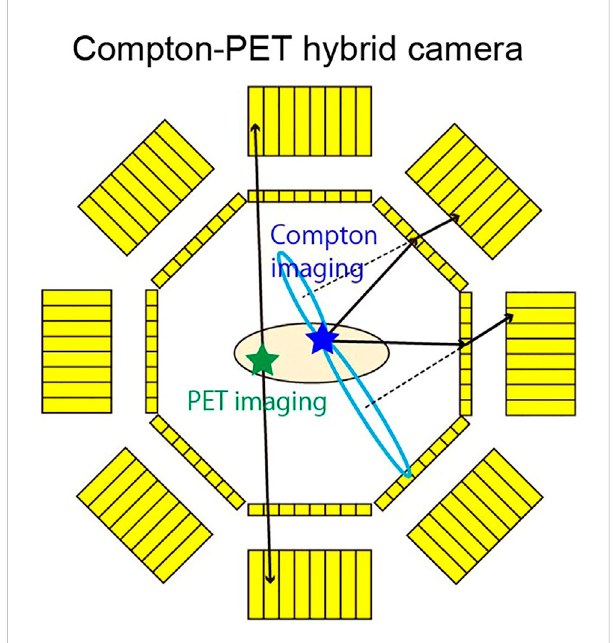
FIGURE 9 Compton-PET Hybrid camera. Both PET and SPECT tracers can be imaged with this camera. The thick yellow boxes represent absorbers. The thin yellow boxes represent scatterers. Coincident detection of annihilation photons (green star and black arrows) is done via the absorbers, similar to traditional PET systems. SPECT tracers (blue star) are visualized by using coincident detection of a scattered gamma ray in a scatterer, and an absorbed gamma ray in an absorber. The solid black arrows represent gamma rays scattering in different scatterers, then being absorbed by different absorbers. Dashed lines are the axes of the Compton cones. Blue ovals are the base of the Compton cones. Reproduced under CC-BY license 4.0 from